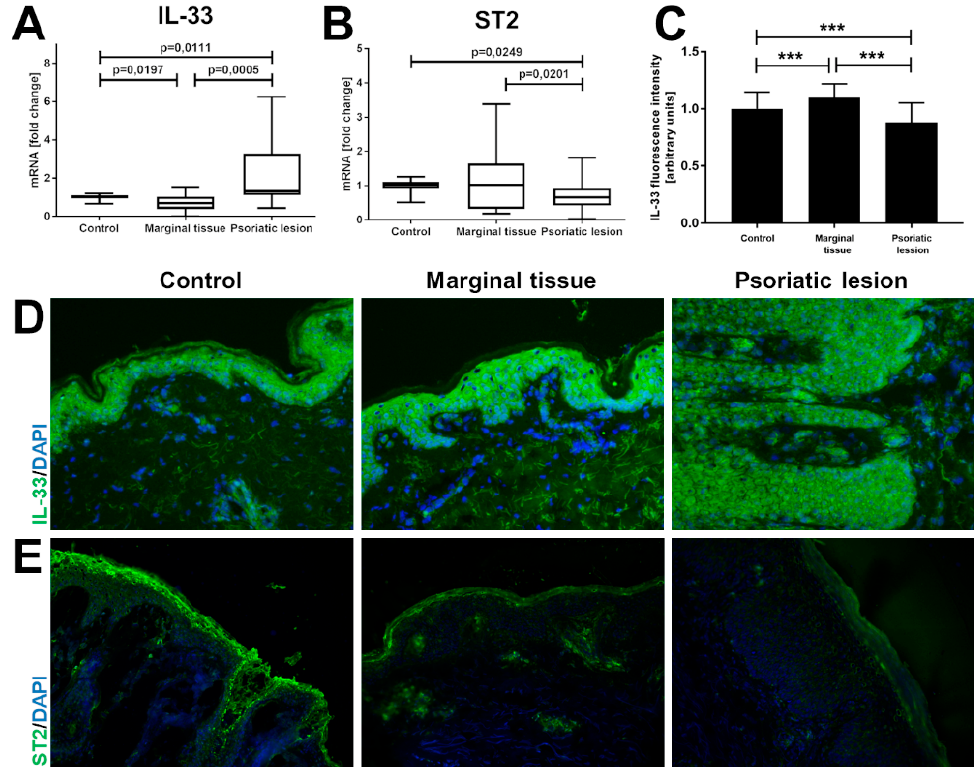
Figure 6. Changes in the expression of IL-33 and ST2 in psoriatic skin compared to controls at the mRNA and protein levels. Relative mRNA levels of IL-33 ( A ) and ST2 ( B ) were analyzed by quantitative real-time PCR in perilesional ( n = 18) and lesional psoriatic skin ( n = 18) compared with healthy control subjects ( n = 13), as described in the methodology. Results are presented as boxes with min to max whiskers. Representative images of IF of psoriatic skin and healthy skin at 200× magnification are shown in ( D , E ). Skin samples were stained with rabbit polyclonal antibody to IL-33 ( C , D ) and rabbit polyclonal antibody to ST2 ( E ). *** p < 0.001.